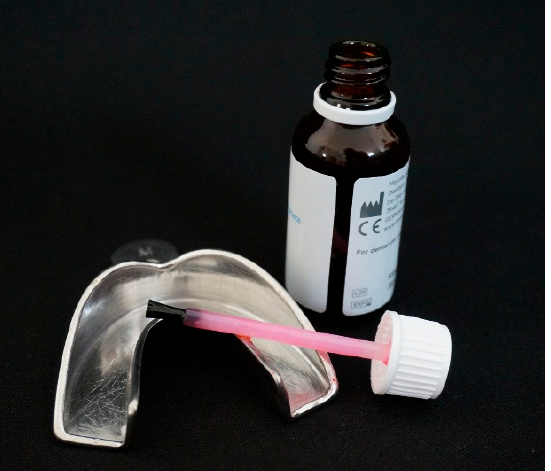
Figure 1. Impression tray, reusable brush, and adhesive flask (sample).